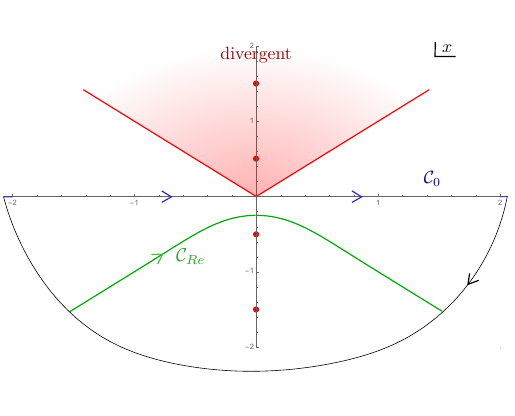
Figure 1 . The integration contour in the complex x -plane. The blue contour, axis, whereas the green contour, the integrand in the expression for the spectral Z functions in (4.16), explicitly remains real along the entire contour, here plotted for m 2 = 0 : 5 (and m 1 = 0). The shaded red region corresponds to the region where the integrand diverges as and realising that the arc lies completely in the region where H cl: these two integration contours gives the same result since the deformation does not cross any